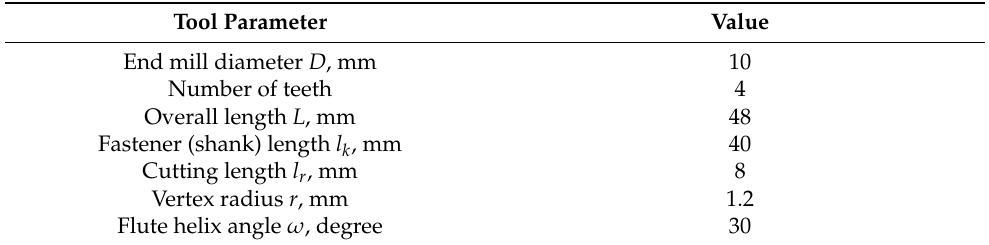
Table 1. The geometric design of solid ceramic end mills for development and testing purposes.